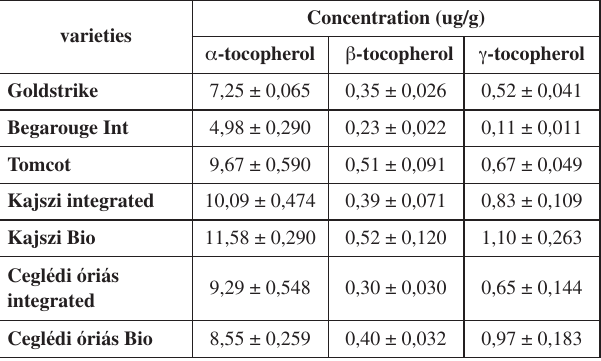
Table2. Composition and content of vitamin E components extracted from apricot fruits of different varieties and analysed by HPLC